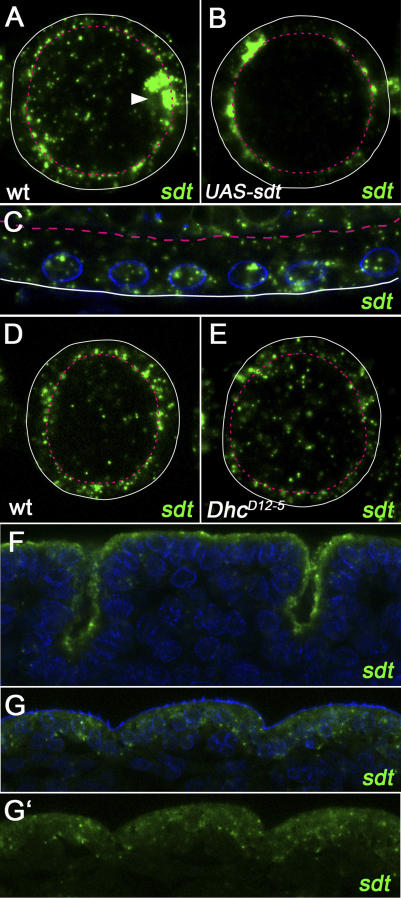
The Apical Localization of sdt mRNA Is Dynein-dependent and Developmentally RegulatedFluorescent in situ hybridization (green) reveals the localization of the sdt mRNA in the FCs (A–E) and embryonic surface ectoderm (F and G).(A–E) Pink lines denote the estimated position of the apical surface, and white lines mark the basal surface.(C), (F and G) Nuclear envelopes are stained with wheat germ agglutinin (WGA, blue).(A) At stages 2–4, sdt mRNA forms a punctate ring at the apical FC surface. An arrowhead points to sdt mRNA localization in the germline, which is better shown in Figure S3.(B) Over-expression of the sdt cMAGUK transgene in the FCs reveals strong apical transcript localization.(C) At stage 10, sdt mRNA is uniformly distributed in the FC cytoplasm. The apical ring of sdt puncta normally observed in wild-type egg chambers (D) disappears when the entire epithelium is mutant for DhcD12
−5 (E).(F) At embryonic stage 11, sdt transcripts are strongly enriched in the apical cytoplasm, but appear to be uniformly distributed by stage 15 (G and G')